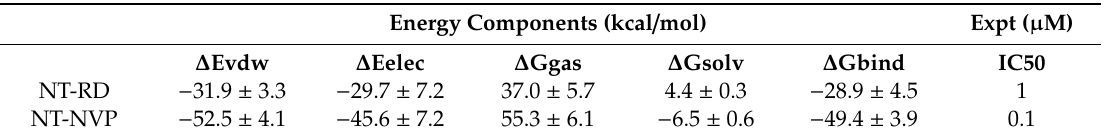
Table 3. Summary of molecular mechanics / generalized born surface area (MM / GBSA)-based binding free energy contributions and IC 50 of RD and NVP bound to the ATP-binding pocket of Hsp90. Energy Components (kcal / mol)